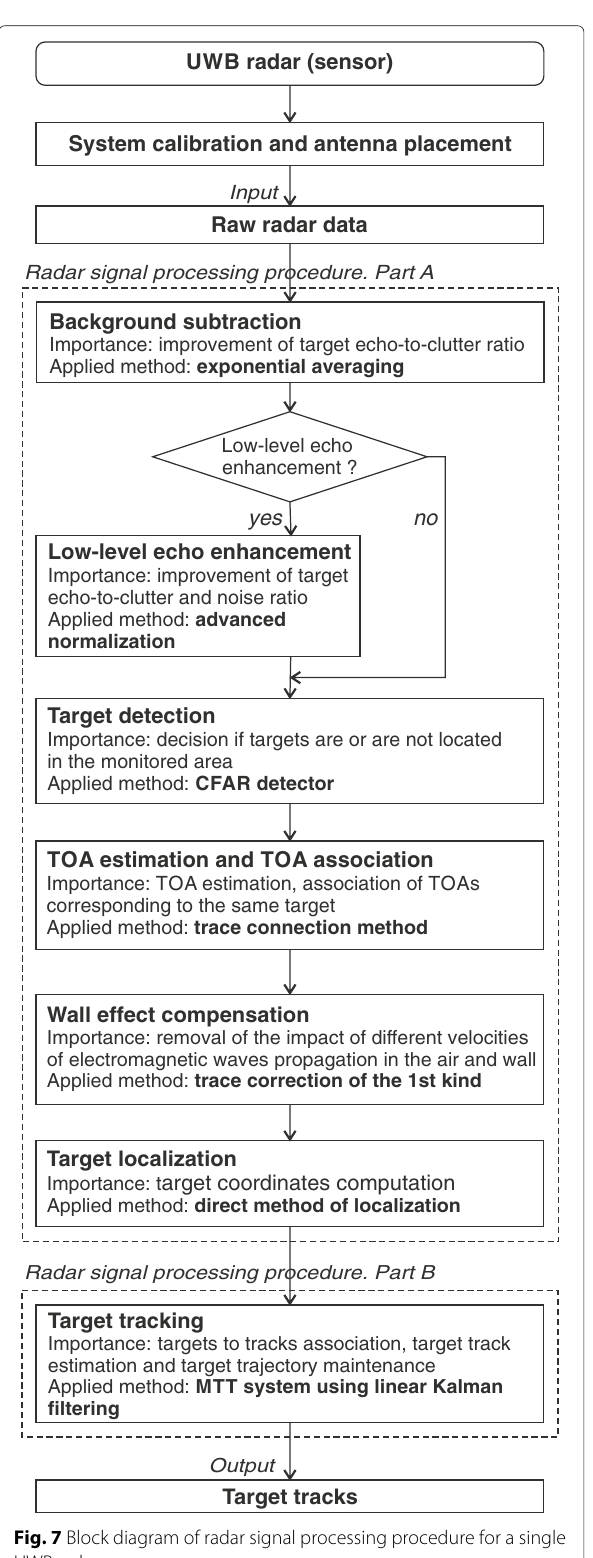
Fig. 7 Block diagram of radar signal processing procedure for a single UWB radar